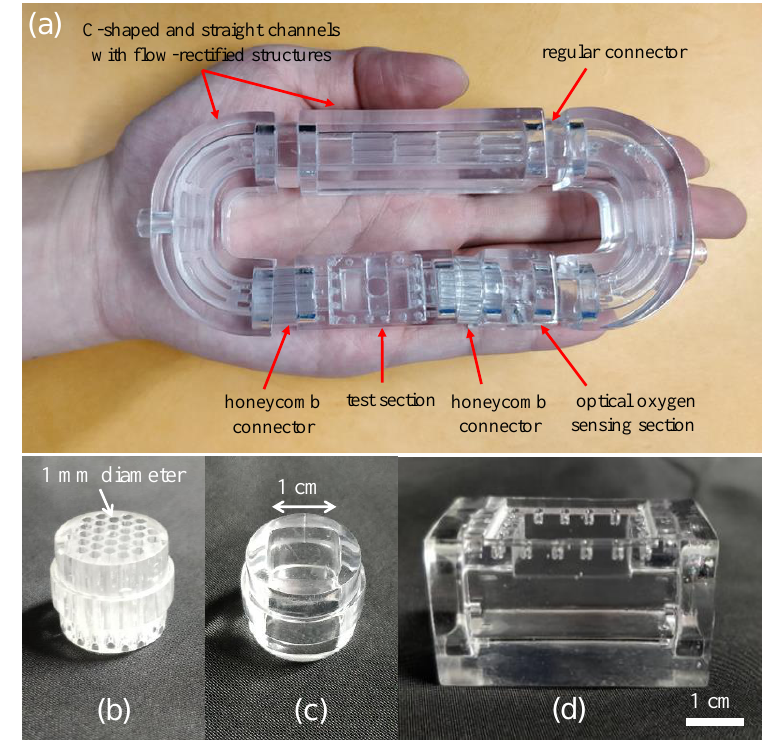
Figure 2. ( a ) An image of a 3D-printed, palm-sized zebrafish treadmill with a 20 mL water volume consisting of discrete components assembled together like modules. Images of ( b ) honeycomb screen connector, ( c ) regular connector and ( d ) a test section to accommodate a single zebrafish.